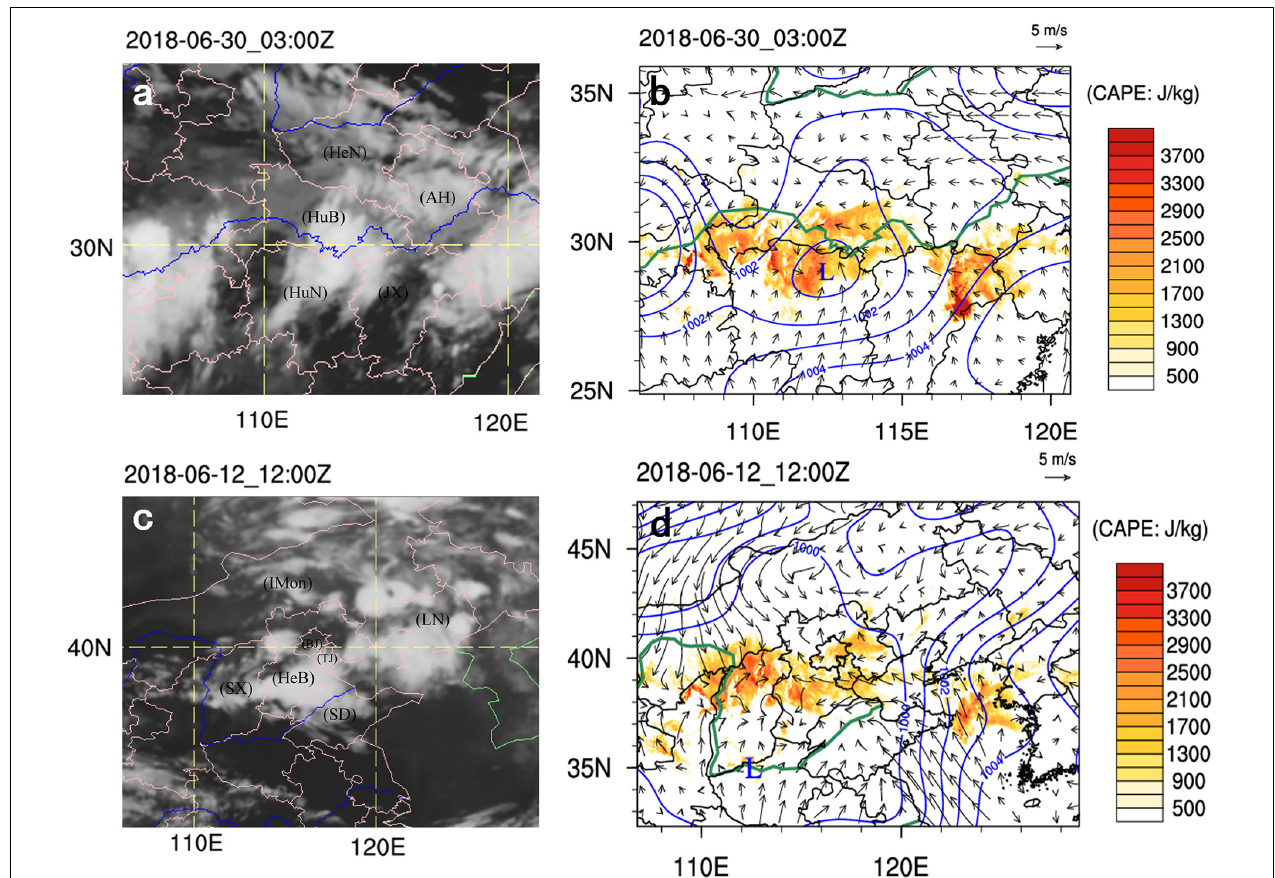
FIGURE 2 | Infrared image from the FY2 geostationary satellite (a,c) and the synoptic analysis derived from the 0.25 ◦ Global Forecast System (GFS) reanalysis (b,d) . The shaded colors in (b,d) represent the maximum convective available potential energy, the solid blue lines represent the contours for sea level pressure, and wind arrows are for the 10 m wind vectors. (a,b) Case 1 at 0300 UTC on 30 June 2018. (c,d) Case 2 at 1200 UTC on 12 June 2018. The abbreviations are the same as in Figure 1